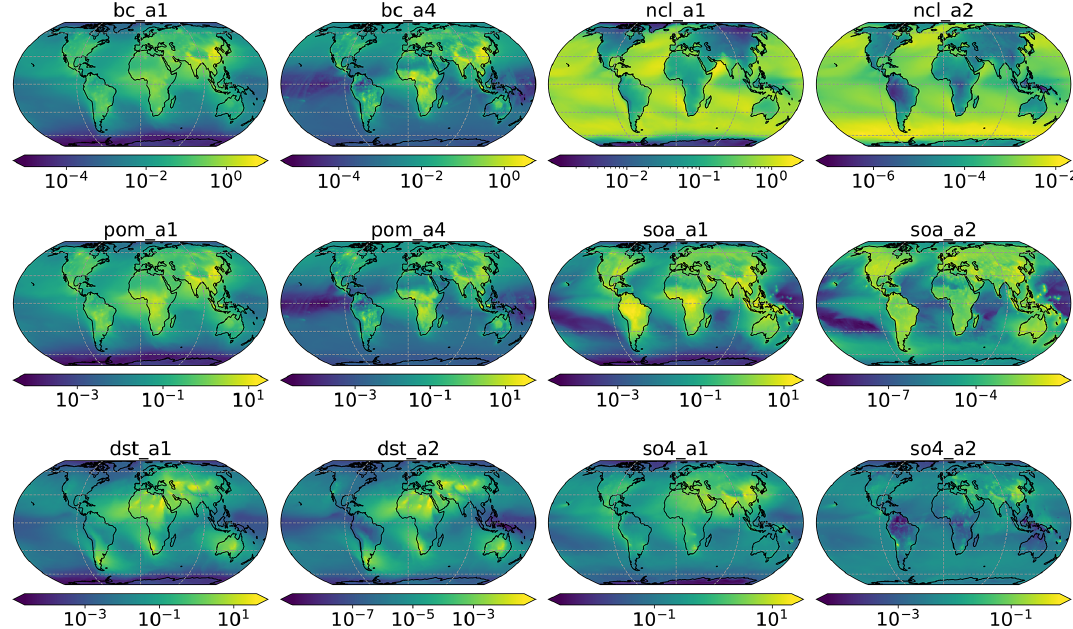
Figure A1. Aerosol species mixing ratio (µgkg − 1 ). Accumulation mode: a1; Aitken mode: a2; primary carbon mode: a4. The coarse mode (a3) is not used in this study and therefore omitted in this figure. Black carbon: bc; dust: dst; sea salt: ncl; primary organic matter: pom; secondary organic aerosol: soa; sulfate: so4.